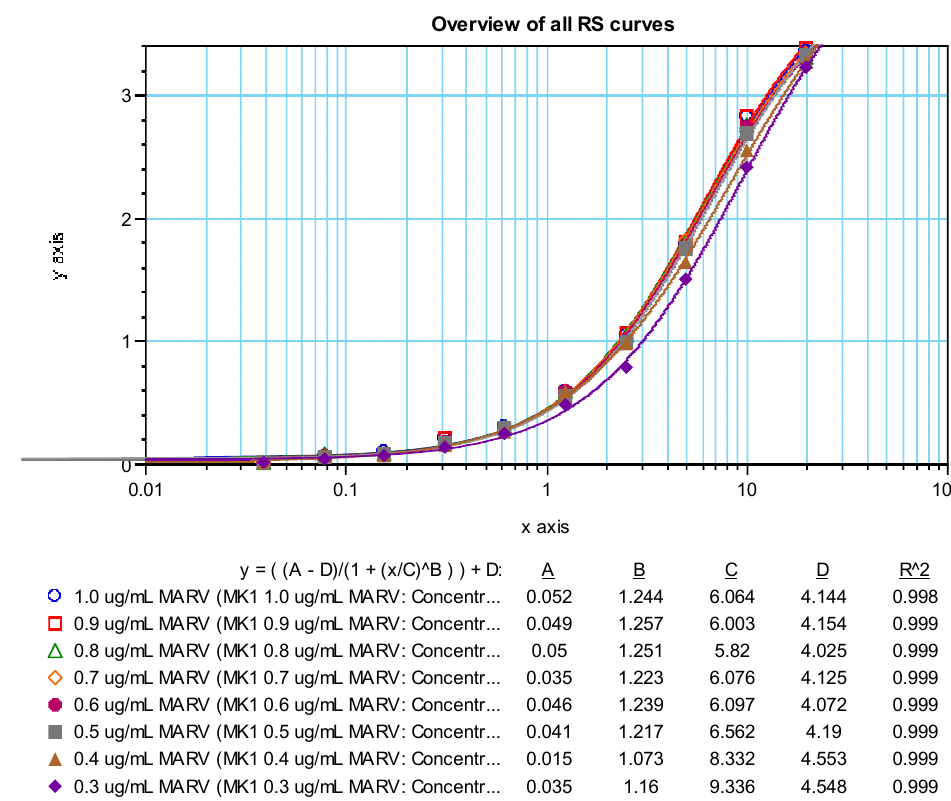
Figure 6. Coating Antigen Optimization 4PL Curve